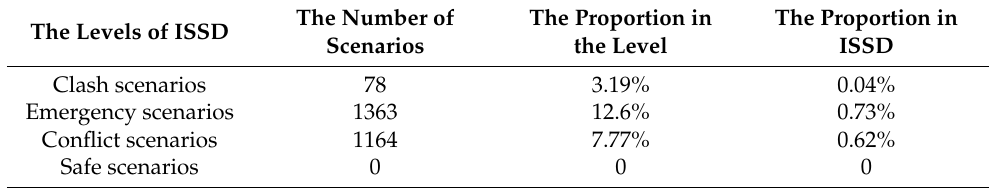
Table 9. The critical scenarios in ISSD.